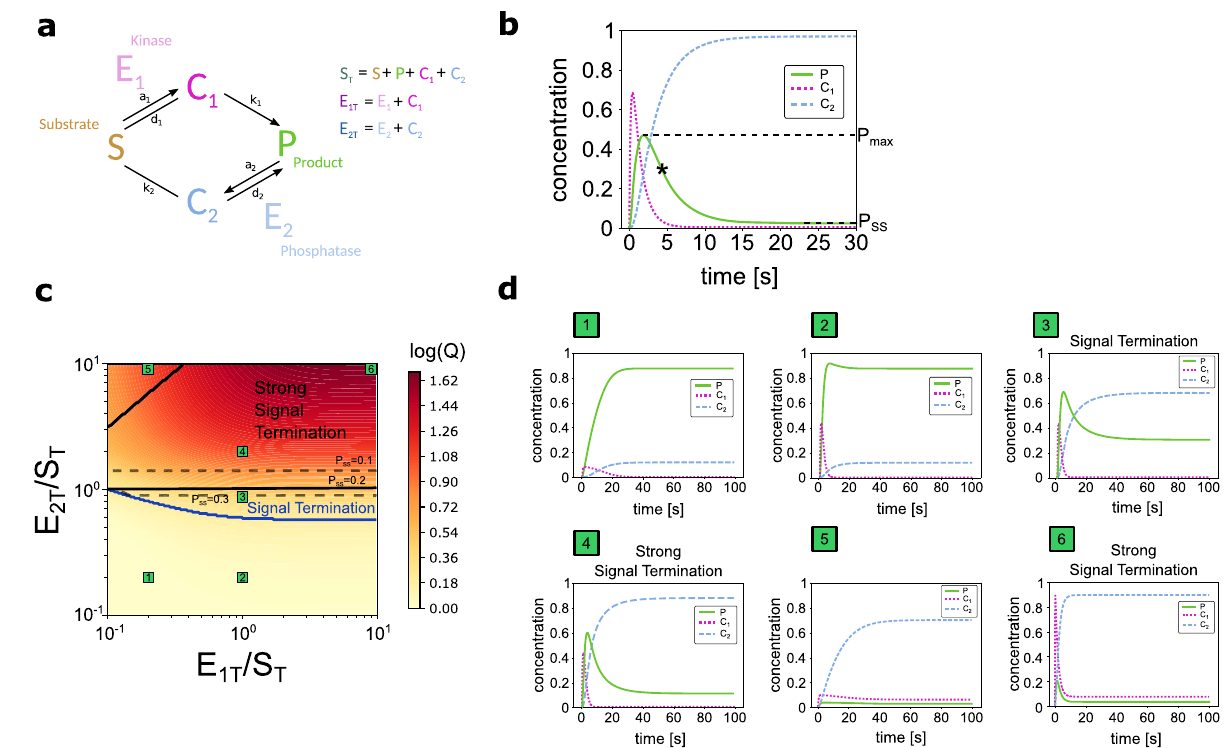
Fig. 1 Signal termination in a CMC: the importance of the relative concentrations between substrate and enzymes. a Scheme representing a CMC cycle. S is the unmodi fi ed substrate, P the product (modi fi ed substrate), E 1 and E 2 are the modifying enzymes (kinase and phosphatase), C 1 is the substrate – kinase complex, C 2 is the product-phosphatase complex. Three kinetic parameters are associated with each enzymatic reaction, a i , d i , and k i : the association, dissociation, and catalytic rates, respectively (more details in the Methods section). b Phosphorylated protein ( P , solid green line), substrate – kinase complex ( C 1 , dotted pink line), and product-phosphatase complex ( C 2 , dashed blue line) are plotted versus time. Parameter values: a 1 = 3.5; d 1 = 1; k 1 = 50; a 2 = 0.3; d 2 = 0.25; k 2 = 0.25; E 1T = 100; E 2T = 100; S T = 35. a i , i = 1,2, are in units of 1/(time × concentration), d i and k i are in units of 1/time, the total enzymes ( E 1T and E 2T ) are in units of concentration (see Methods section). P max and P ss , the maximum and the steady-state levels of P , are indicated over the plot. The characteristic value 0.63 × P max is indicated with an asterisk over the time course. c Graphs of Q ( = P max / P ss ) versus E 1T / S T and E 2T / S T , with Q in color scale. E 1T / S T , E 2T / S T , and Q are in logarithmic scale, E 1T / S T and E 2T / S T vary between 0.1 and 10, resulting in Q values in the range between 1 and ~46. The solid blue line over the plots corresponds to Q = 1.6 and separates signal termination from monotonic behavior and non-monotonic behavior not satisfying the criteria. The solid black line over the plot corresponds to P ss = 0.2. The cases over the line ( P ss > 0.2) are termed strong signal termination. Dashed black lines correspond to P ss = 0.1 or 0.3, indicating different boundaries for the strong signal termination region. On the upper left triangle, Q < 1.6 (no signal termination satisfying the criteria). The kinetic parameter values are as in b . d Representative time courses in different regions in c . Parameter set 1: E 1T / S T = 0.13, E 2T / S T = 0.13, parameter set 2: E 1T / S T = 1, E 2T / S T = 0 . 13, parameter set 3: E 1T / S T = 1, E 2T / S T = 0 . 79, parameter set 4: E 1T / S T = 1, E 2T / S T = 1 . 26, parameter set 5: E 1T / S T = 0.13, E 2T / S T = 7.9, parameter set 6: E 1T / S T = 7.9, E 2T / S T =